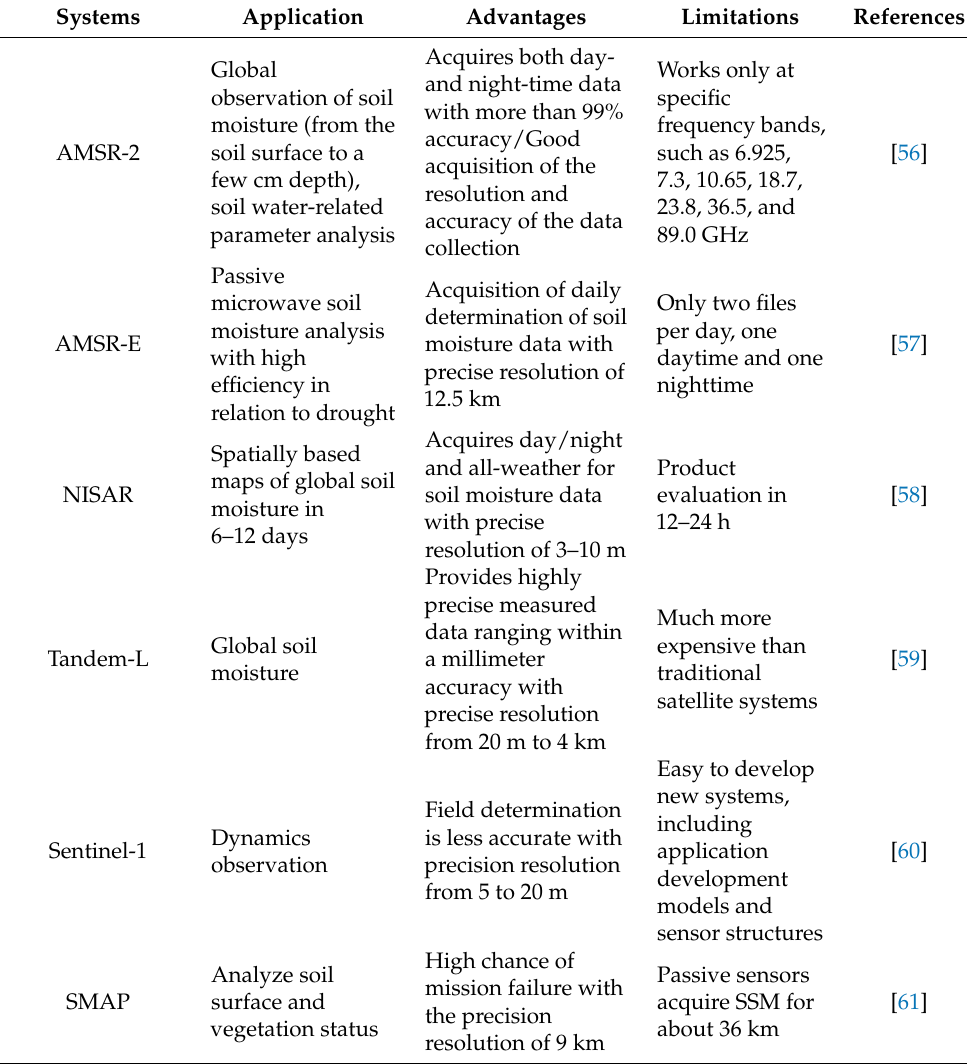
Table 1. Satellites that monitor global soil moisture content with major applications and their respective advantages and